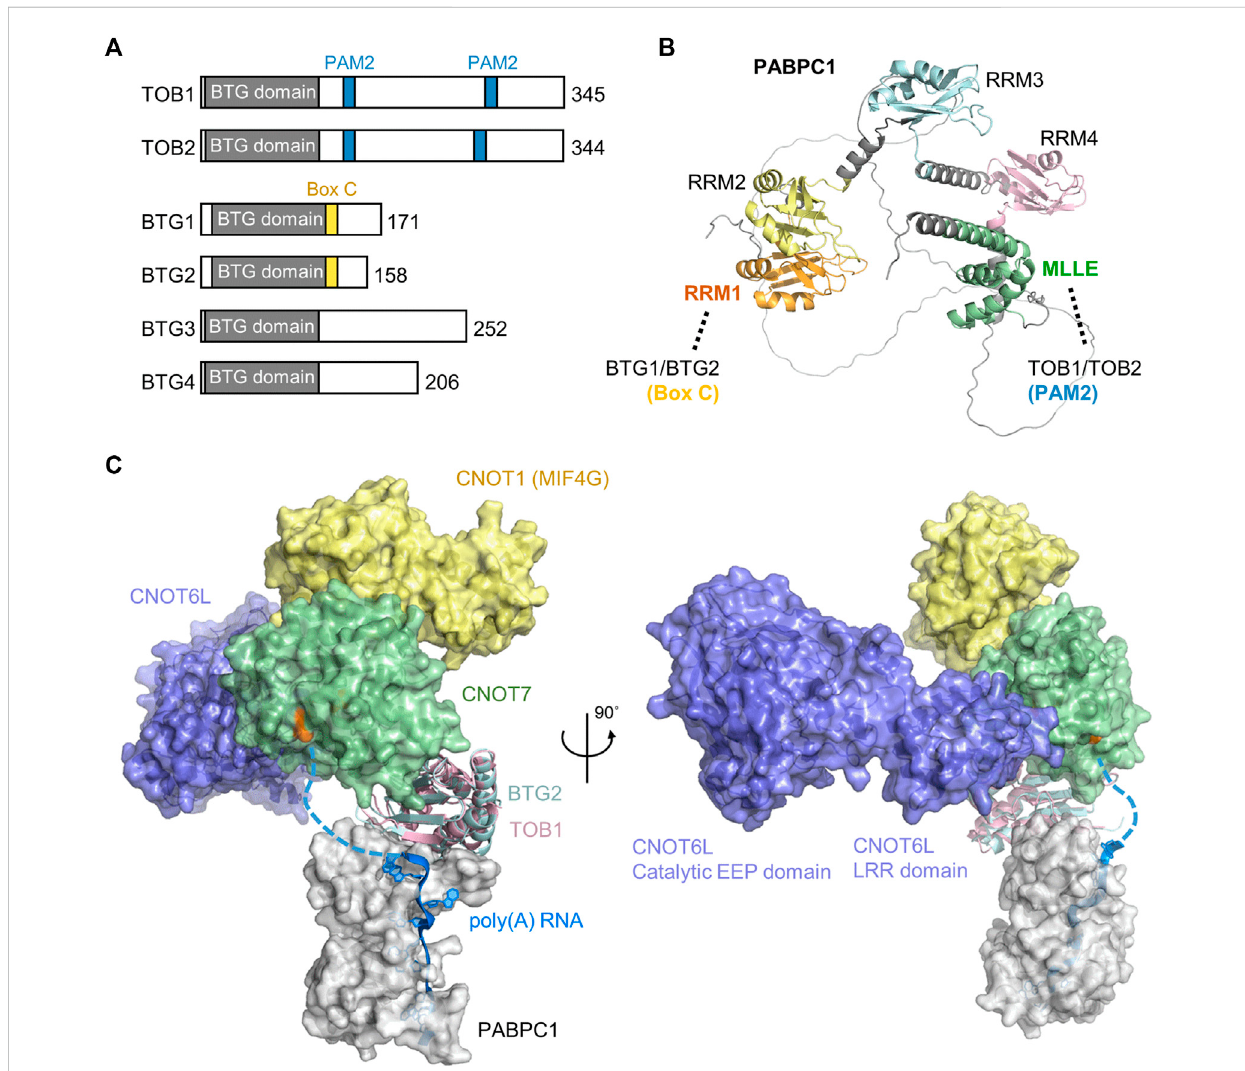
FIGURE 5 Recruitment of the Ccr4-Not complex by PABPC1. (A) Overview of the BTG/TOB proteins. Indicated are the conserved BTG (APRO) domain (grey), PAM2 motifs present in TOB1 and TOB2 (blue), and Box C regions in BTG1 and BTG2 (yellow). (B) Model of Hs PABPC1 (Uniprot P11940) (Jumper et al., 2021). Indicated are RRM1 (orange) that interacts with Box C regions of BTG1/BTG2, RRM2-RRM4 (yellow, light blue, pink), and the MLLE domain (green) interactingwithPAM2motifsofTOB1/TOB2. (C)